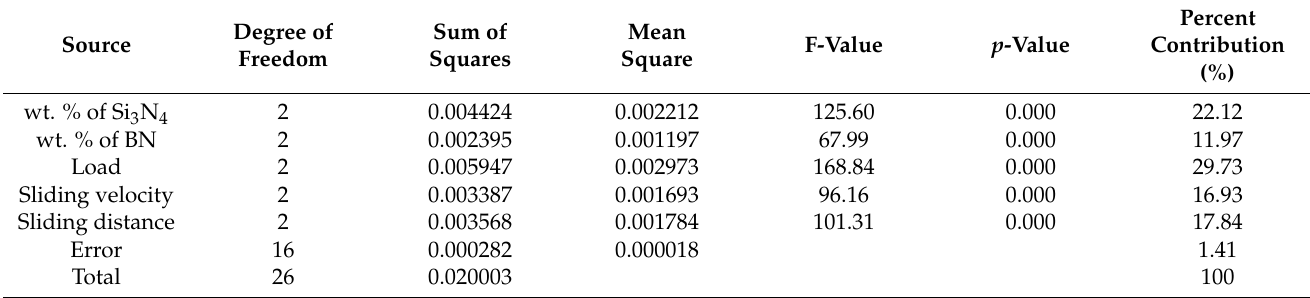
Table 7. Statistical analysis of variance for COF.